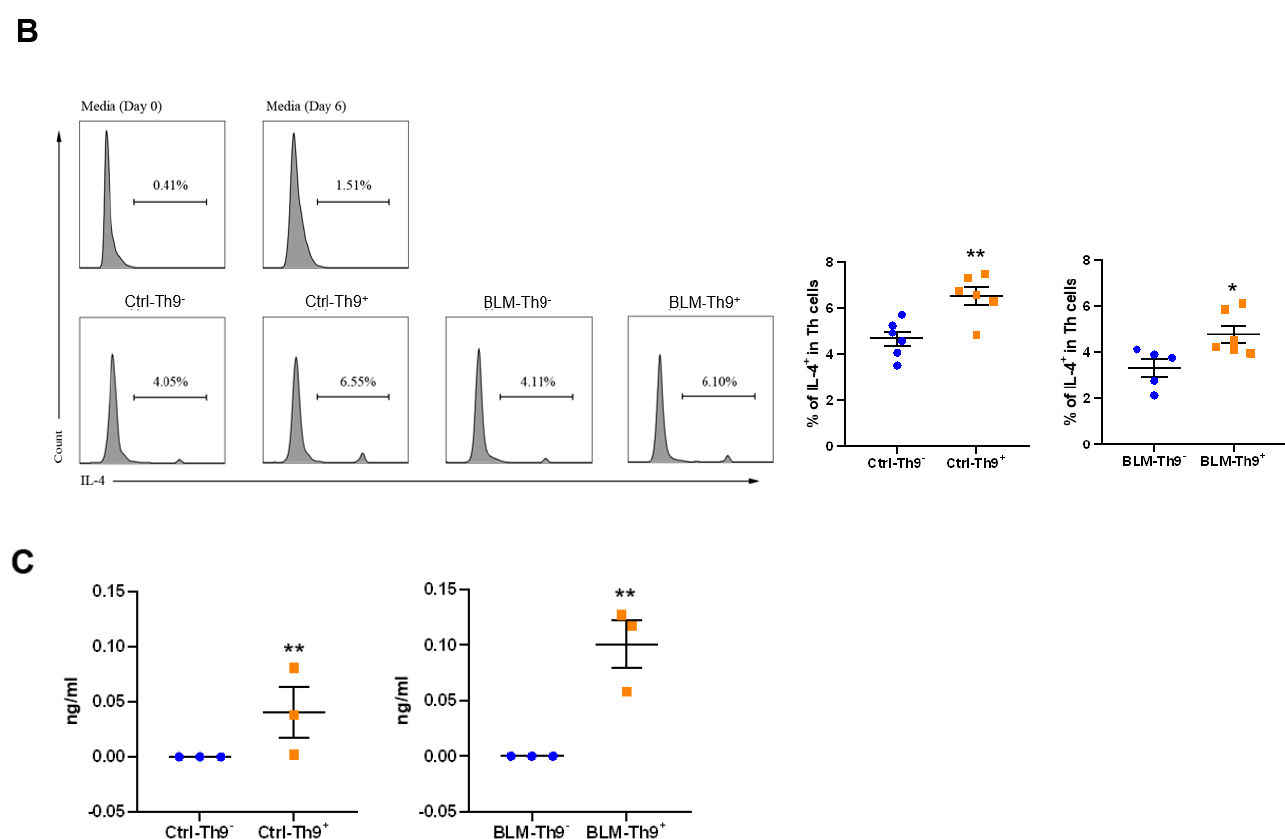
Figure 4. Th9 cells promote Th0 cells (Naive CD4 + T cells) differentiating to Th2 cells and induce lung fibroblasts to secrete more collagen. ( A ) Flowchart of the co-culture assay. ( B ) Co-culture of Th9 cells and Th0 cells promotes the differentiation of Th0 cells to Th2 cells ( n = 5 to 6). ( C ) Co-culture of Th9 cells and lung fibroblasts induces fibroblasts to secrete more collagen ( n = 3). p values were determined by two-sided Student’s t -test. Data were expressed as mean ± SEM. * p < 0.05; ** p < 0.01.